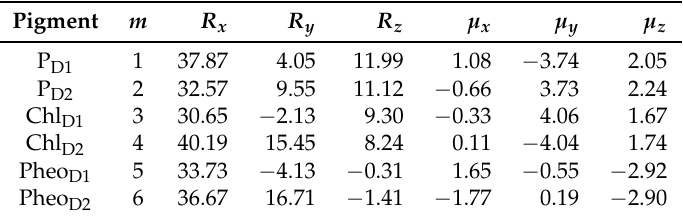
Table A2. Data of pigment sites adapted from Gelzinis et al. [21]. The coordinates of geometric center of pigment, R = ( R x , R y , R z ) , are in units of Å, and the transition dipole moment of pigment, µ = ( µ x , µ y , µ z ) , are in units of debye.